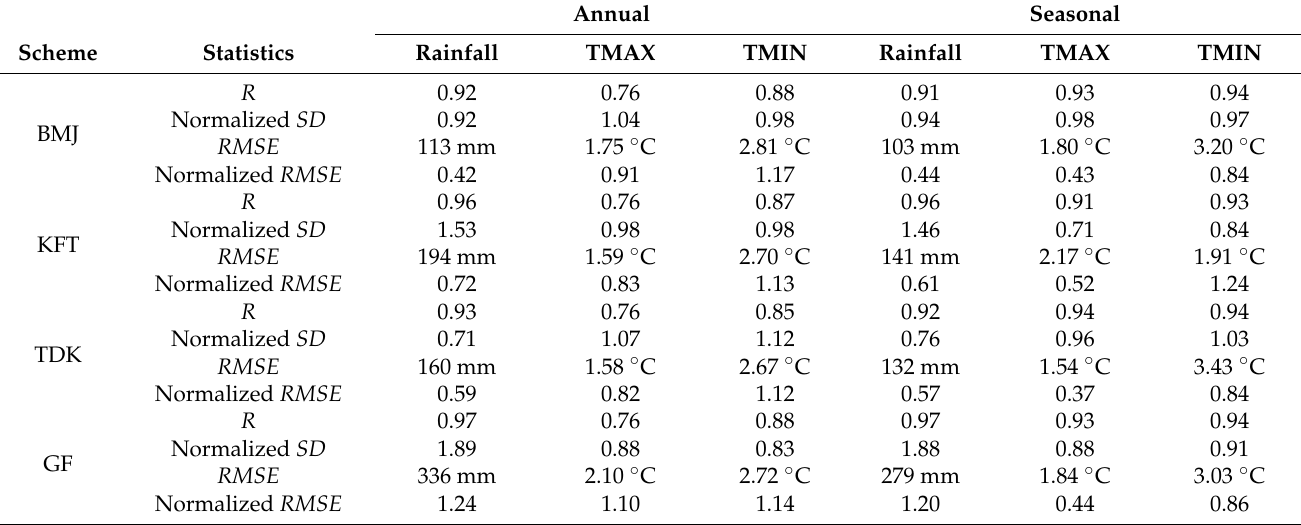
Figure 2. Spatial distributions of the 10-year average annual rainfall (mm) and maximum and minimum temperatures ( ◦ C) simulated with the Betts–Miller–Janjic (BMJ), improved Kain–Fritch (KFT), modified Tiedtke (TDK), and Grell–Freitas (GF) schemes, and IMERG [50] observed rainfall data and MERRA2 [51] observed temperature data in Sudan. ( a ) Rainfall. ( b ) Maximum temperature. ( c ) Minimum temperature. Table 1. The Pearson correlation coefficient ( R ), normalized standard deviation ( SD ), root-mean- square error ( RMSE ) and normalized RMSE for spatial distributions of annual and seasonal rainfall, maximum temperature (TMAX), and minimum temperature (TMIN). All correlation coefficients are significant at p ≤ 0.01. Annual